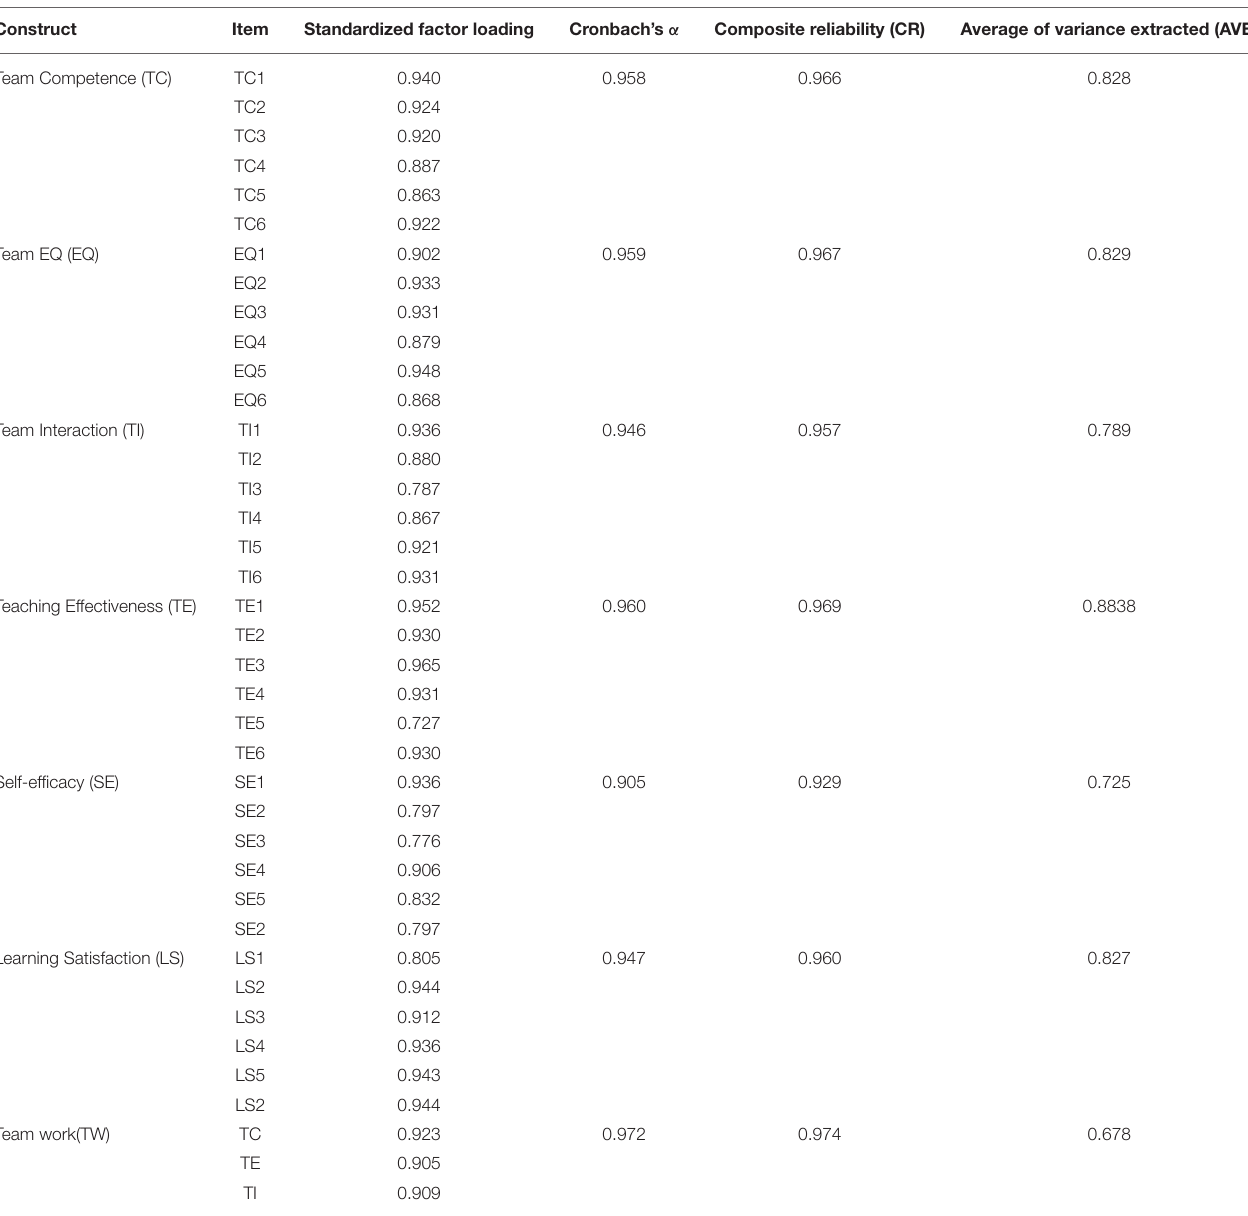
TABLE 4 | Reliability and validity of